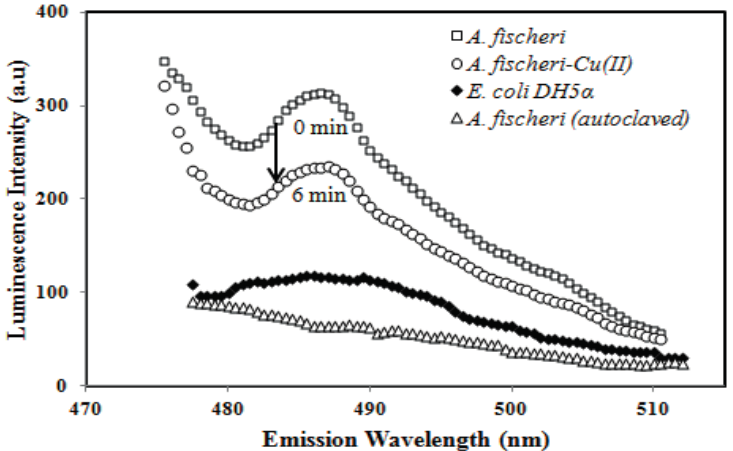
Figure 1. The luminescence response of the microbial biosensor before and after exposure to toxicant of 0.1 mg/L Cu(II), and comparison with luminescence response of immobilized DH5 α E. coli and autoclaved A.